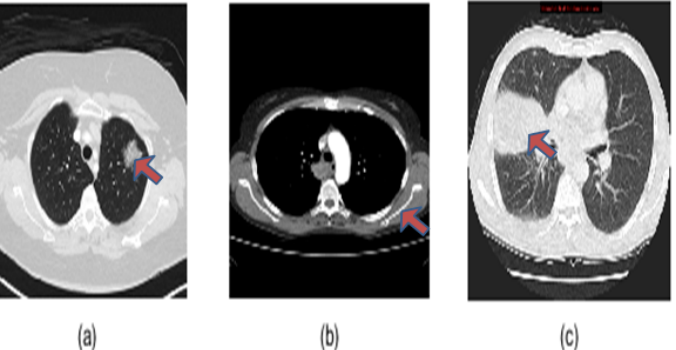
Figure 1. NSCLC radiopathological subtypes manifestations (marked) on CT scans: ( a ) Adenocarci- noma ( b ) Squamous Cell Carcinoma ( c ) Large Cell (undifferentiated)